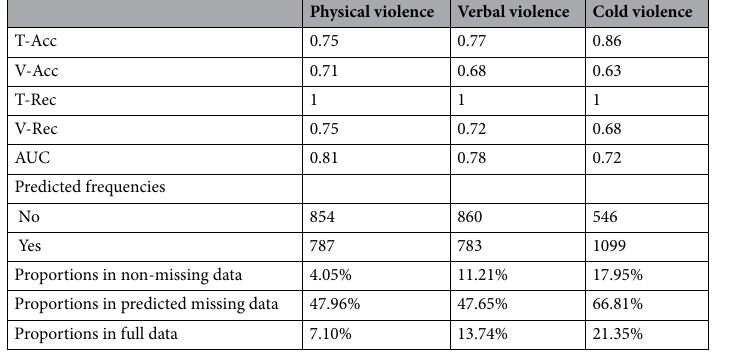
Table 2. Fitness statistics and predicted outcomes of the random forest algorithm. T-Acc accuracy in training set; V-Acc accuracy in validation set; T-Rec recall in training set; V-Rec recall rate in test set; AUC area under the ROC